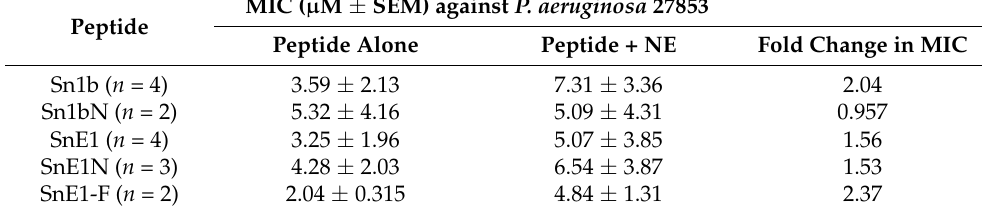
Table 5. MIC values of NE-incubated next generation peptides and parents against P. aeruginosa 27853 following NE incubation. MIC values of NE-incubated peptides against P. aeruginosa 27853 as determined by RDAs. Peptides were incubated with/without 500 nM NE for four hours